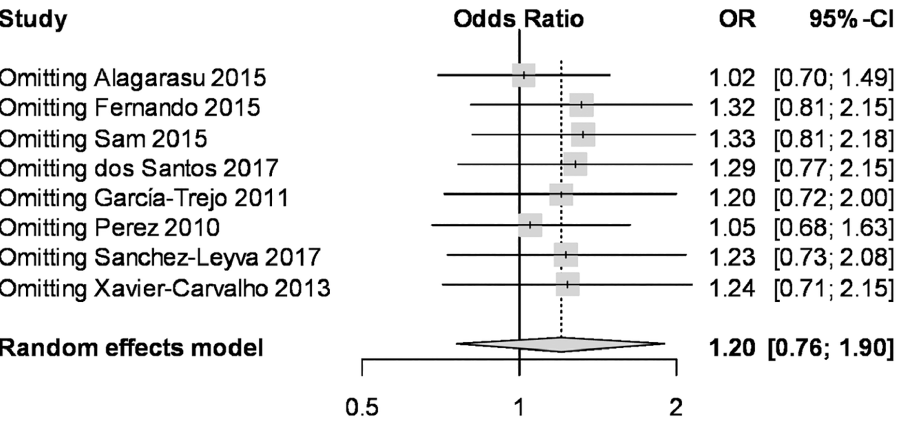
Fig 4. Leave-one-out meta-analysis for the TNF- α -308G > A under the dominant model.